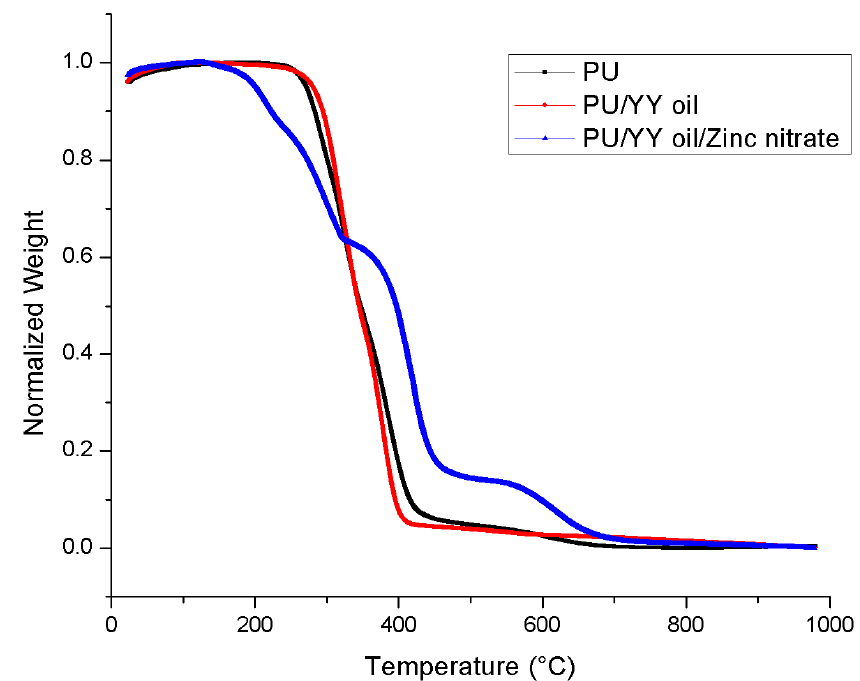
Figure 5. Thermal gravimetric analysis (TGA) of PU, PU/YY and PU/YY/ZnNO 3.